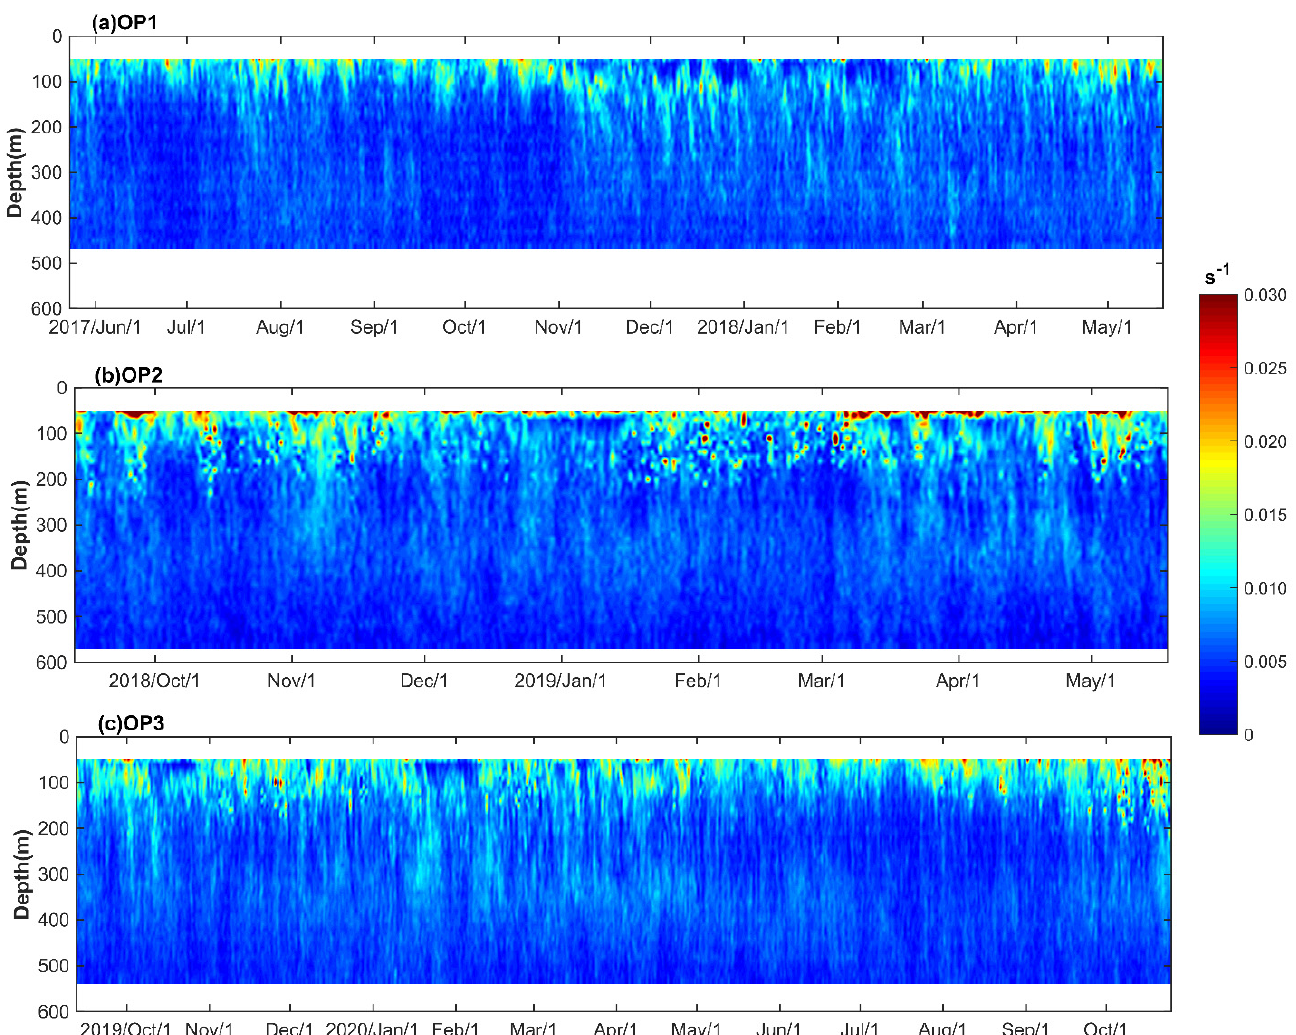
Figure 3. Depth–time map of 36 h low-pass filtered total shear ( a ) for OP1, ( b ) for OP2, and ( c ) for OP3.